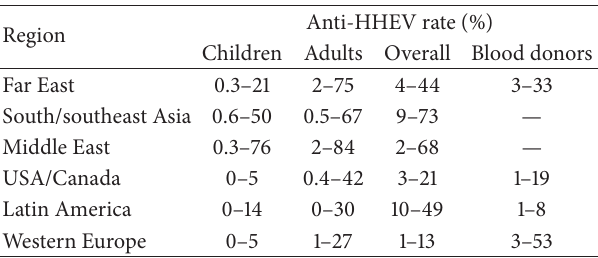
Table 6: Summary of the anti-HHEV prevalence reported from different regions of the